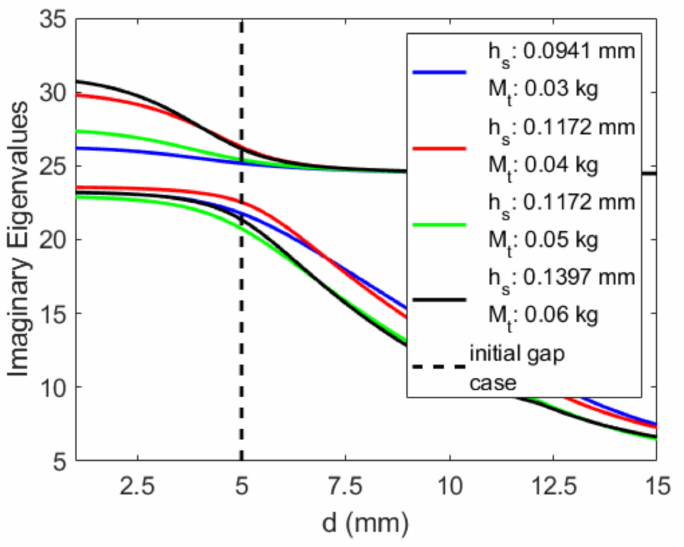
Figure 27. The initial gap’s effects on the coupled natural frequency of varying tip masses with its paired substrate